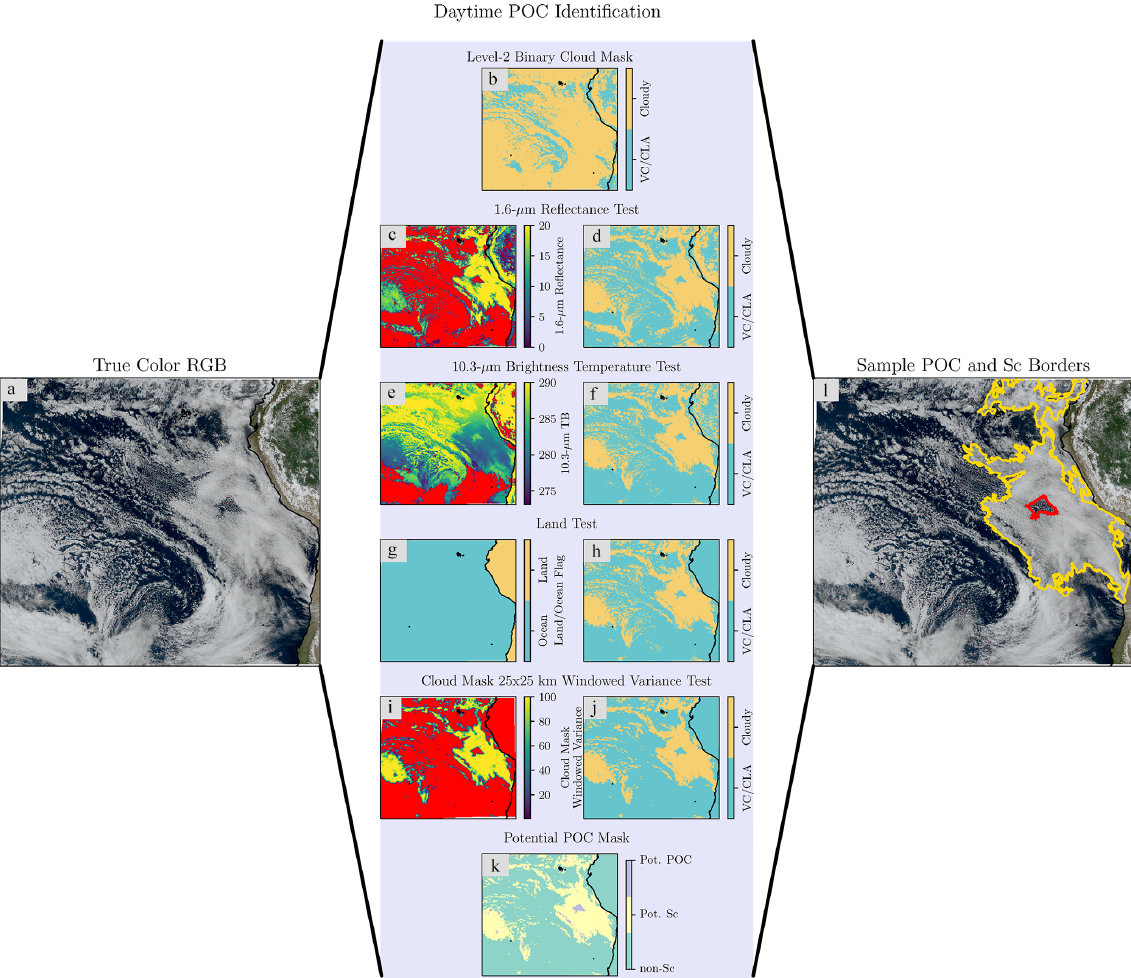
Figure 2. The steps used to identify pockets of open-cell (POCs) stratocumulus during the day. In (l) the stratocumulus deck borders are in yellow and POC borders are in